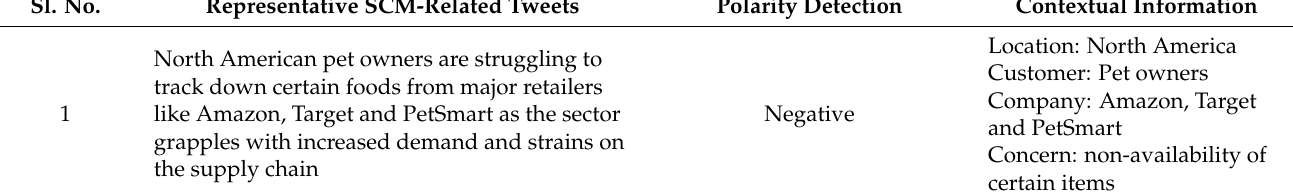
Table 4. Context-aware Sentiment Analysis: The Way Forward.